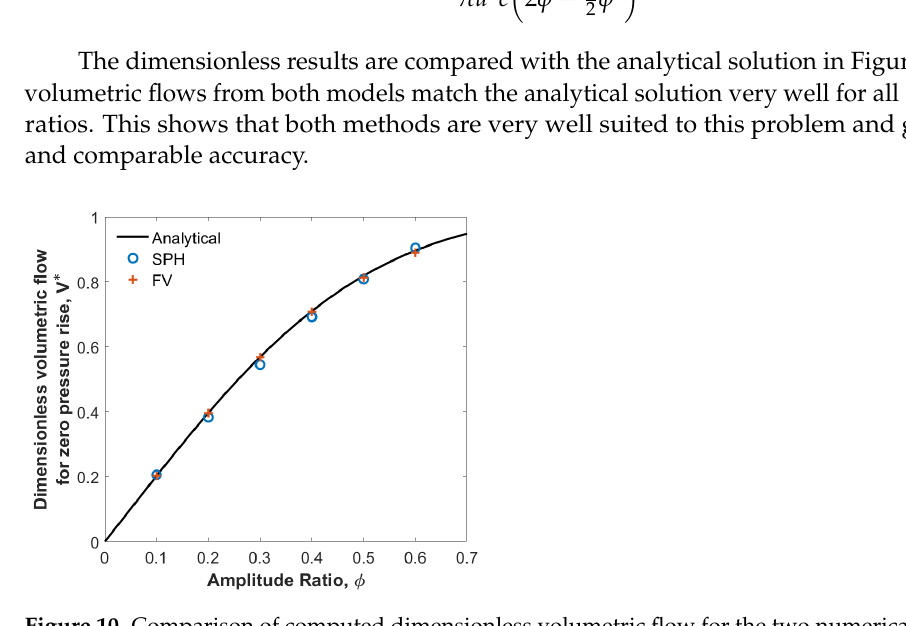
Figure 10. Comparison of computed dimensionless volumetric flow for the two numerical methods with the analytical solution. with the analytical